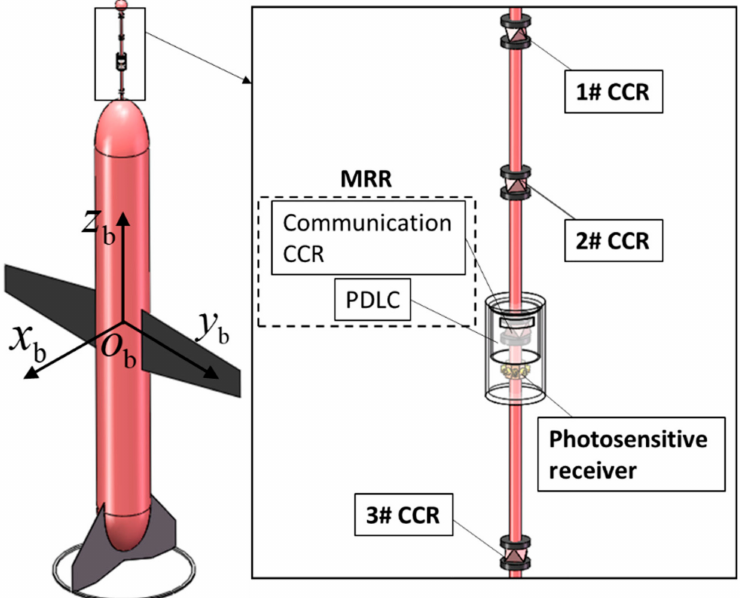
Figure 3. Major components and coordinate system of the retroreflector module mounted on the underwater profiler.